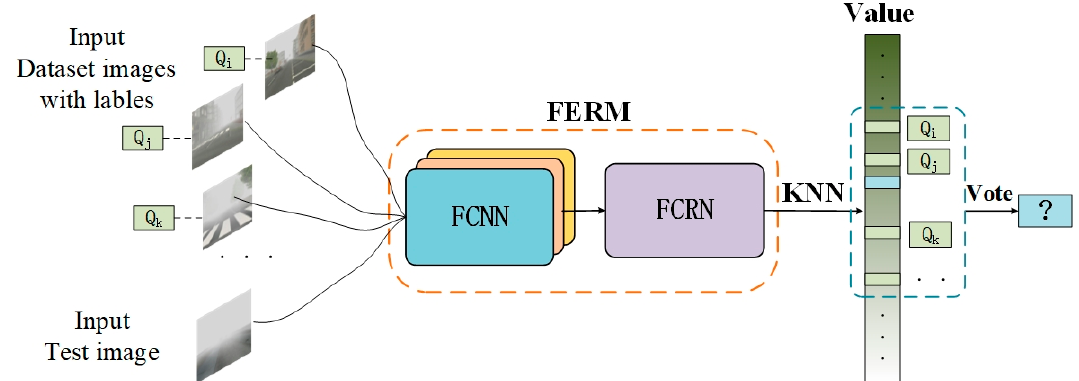
Figure 4. Schematic diagram of testing image visibility level.